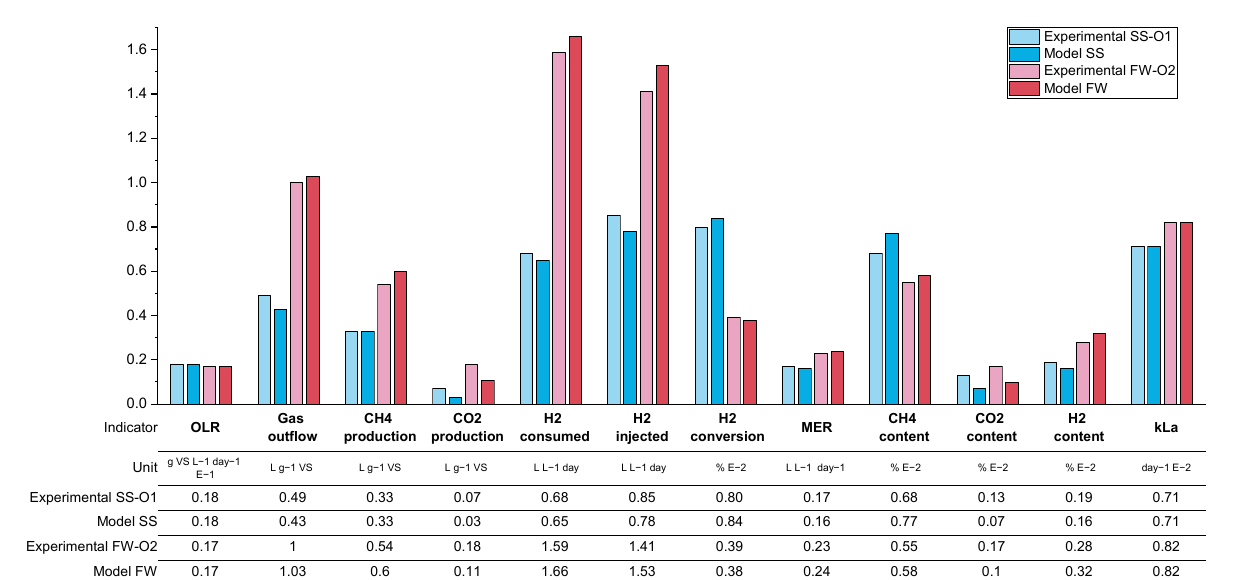
Figure 14. Comparison of the experimental data and modelled data for SS period O1 and FW period O2.